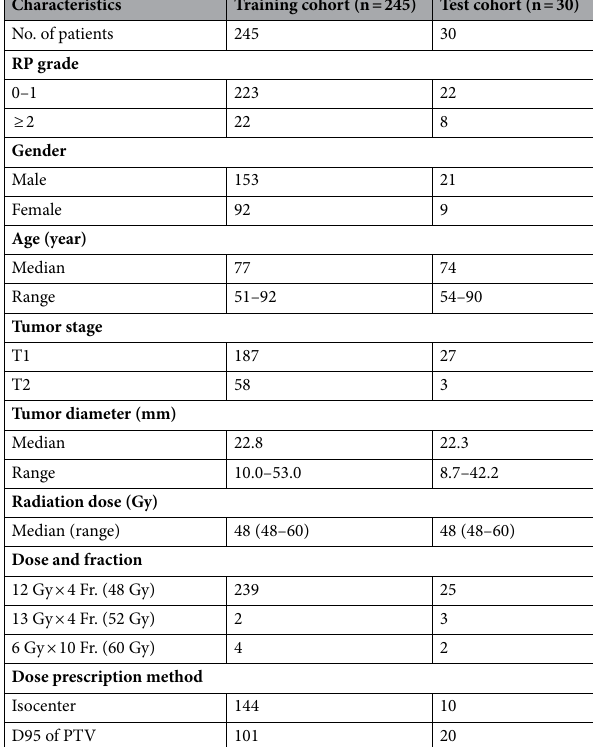
Table 1. Patient